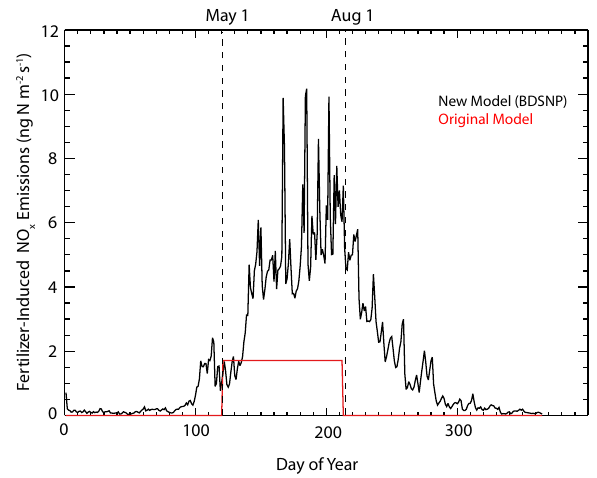
Fig. 3. Mean simulated fertilizer-induced soil NO x emissions over the central United States (103.75–93.75 ◦ W, 27–51 ◦ N) for the orig- inal GEOS-Chem parameterization (red) and the BDSNP